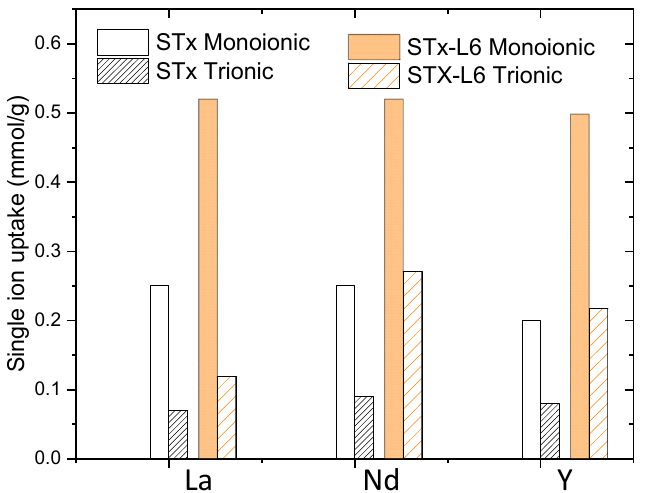
Figure 8. La, Nd, and Y uptakes by pristine STx and modified STx-L6: comparisons between the single ion and trionic solutions (solution ionic concentration = 0.5 mmol ion /g sorbent ).